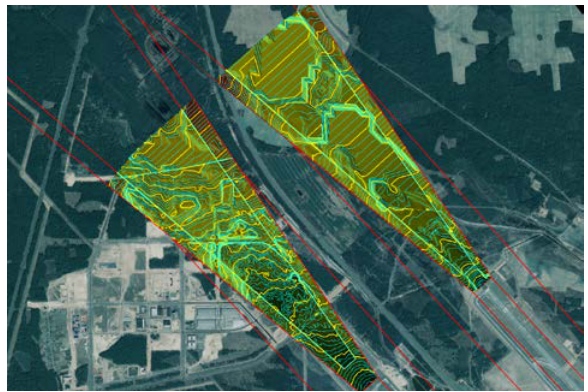
Figure 3. The difference matrix isolines